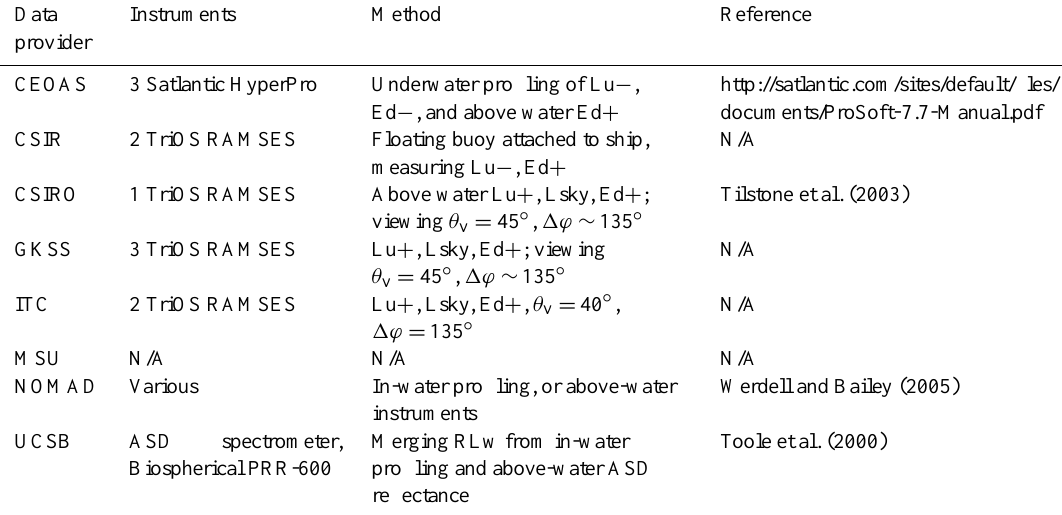
Table 6. Instruments and methods of measurement of RLw in the CCRR match-up data set. θ v and (cid:49)ϕ denote respectively the sensor zenith angle and its azimuth angle relative to the sun. Ed, Lu, and Lsky denote respectively the downwelling irradiance, the upwelling radiance, and the sky radiance measured along the viewing angle θ v . The indices + and − refer to measurements just above and below the water surface